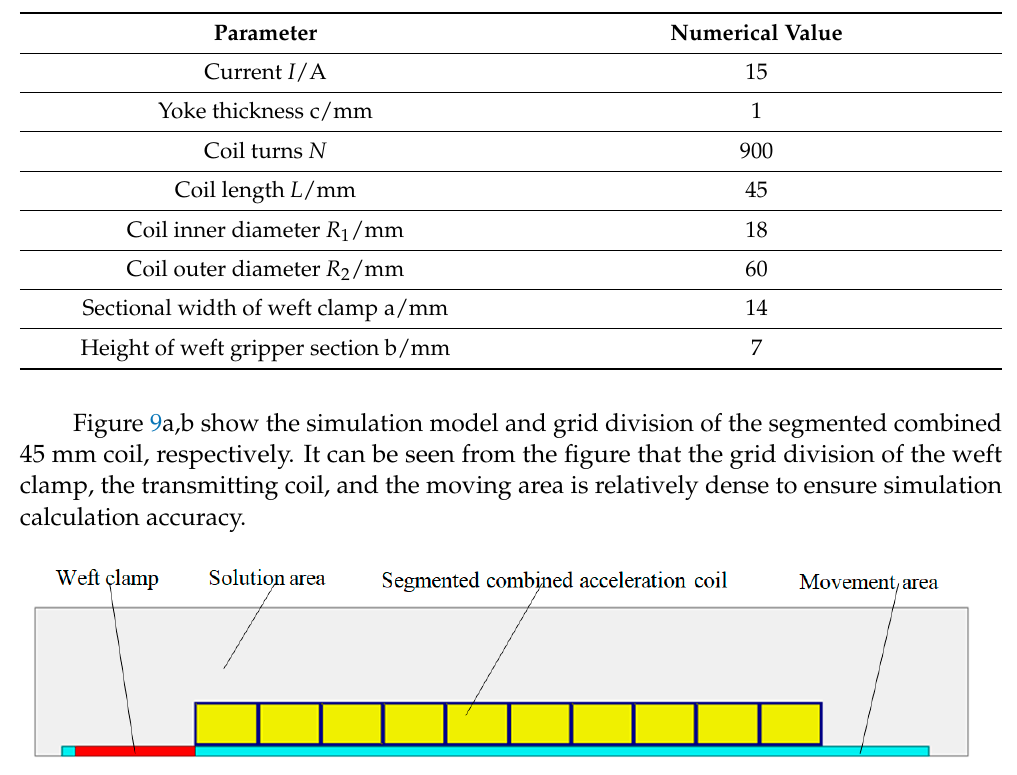
Table 1. Simulation calculation parameters.